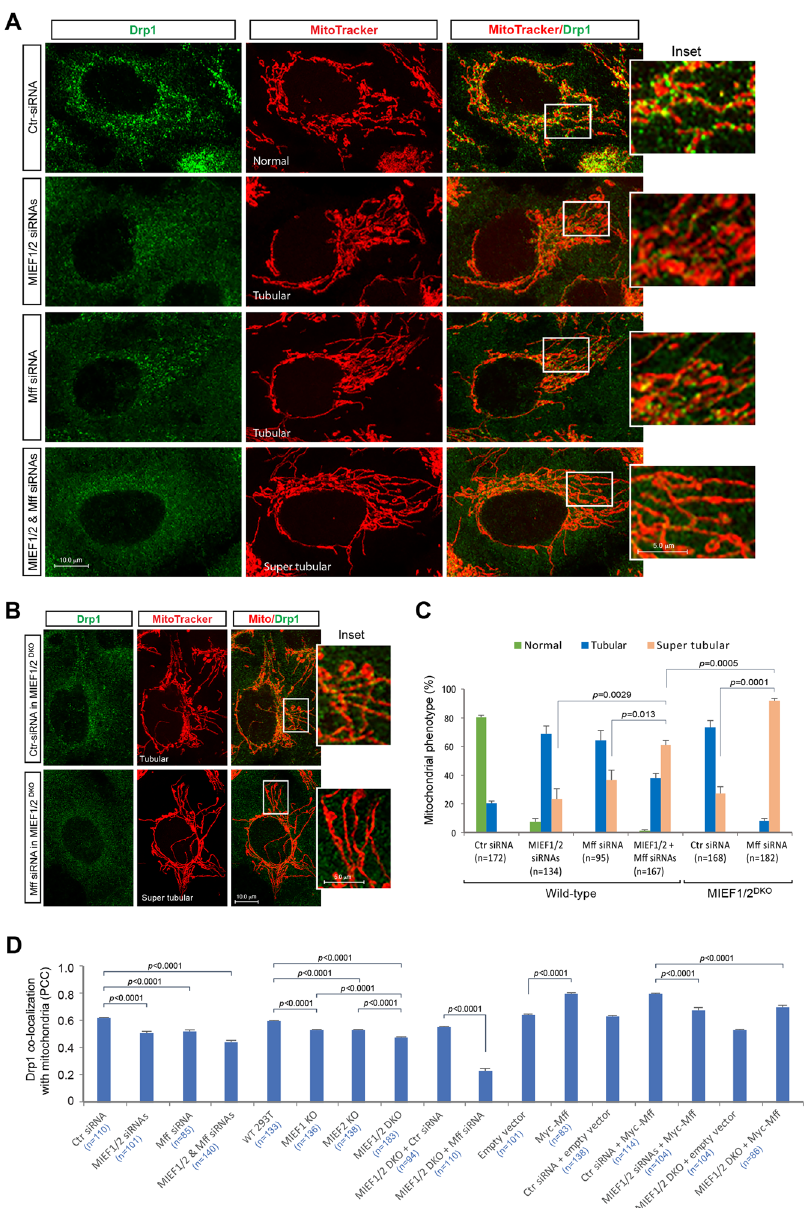
Figure 3. Triple ablation of MIEF1/2 and Mff significantly reduces the distribution of Drp1 on mitochondria, and results in a severe mitochondrial fusion phenotype. ( A ) Effects of triple knockdown of MIEF1/2 and Mff by siRNAs on mitochondrial shape and Drp1 distribution on mitochondria. Confocal images of mitochondrial morphology and Drp1 distribution in 293T cells treated with control siRNA, MIEF1/2 siRNAs, Mff siRNA, and MIEF1/2 siRNAs plus Mff siRNA, and stained with MitoTracker (red) followed by immunostaining with anti-Drp1 (green) antibody. Percentages (mean ± SEM) of cells with indicated mitochondrial morphologies are summarized in ( C ), and quantitative co-localization of Drp1 with mitochondria in different conditions is summarized in ( D ). ( B ) Effects of Mff knockdown by siRNA on mitochondrial shape and Drp1 distribution on mitochondria in the absence of MIEFs. Confocal images of mitochondrial morphology and Drp1 distribution in MIEF1/2 DKO 293T cells treated with control siRNA or Mff siRNA, and stained as in ( A ). Quantitative co- localization of Drp1 with mitochondria is summarized in ( D ). ( C ) Percentages (mean ± SEM) of cells with indicated mitochondrial morphology in wild-type and MIEF1/2 DKO 293T cells transfected with indicated siRNAs in three independent experiments ( ≥ 30 cells were analyzed per experiment). Here the tubular morphology of mitochondria is indicated as moderate (tubular) or “super tubular”. The latter cells display extensively long mitochondria. Total cell numbers (n) used for statistical analysis by the Student’s t -test are indicated in each condition. ( D ) Quantitative co-localization of endogenous Drp1 with mitochondria was analyzed using the Pearson’s correlation coefficient (PCC) (mean ± SEM) in different conditions as indicated. Each set of data is based on three independent experiments. Total cell numbers (n) used for statistical analysis are indicated for each